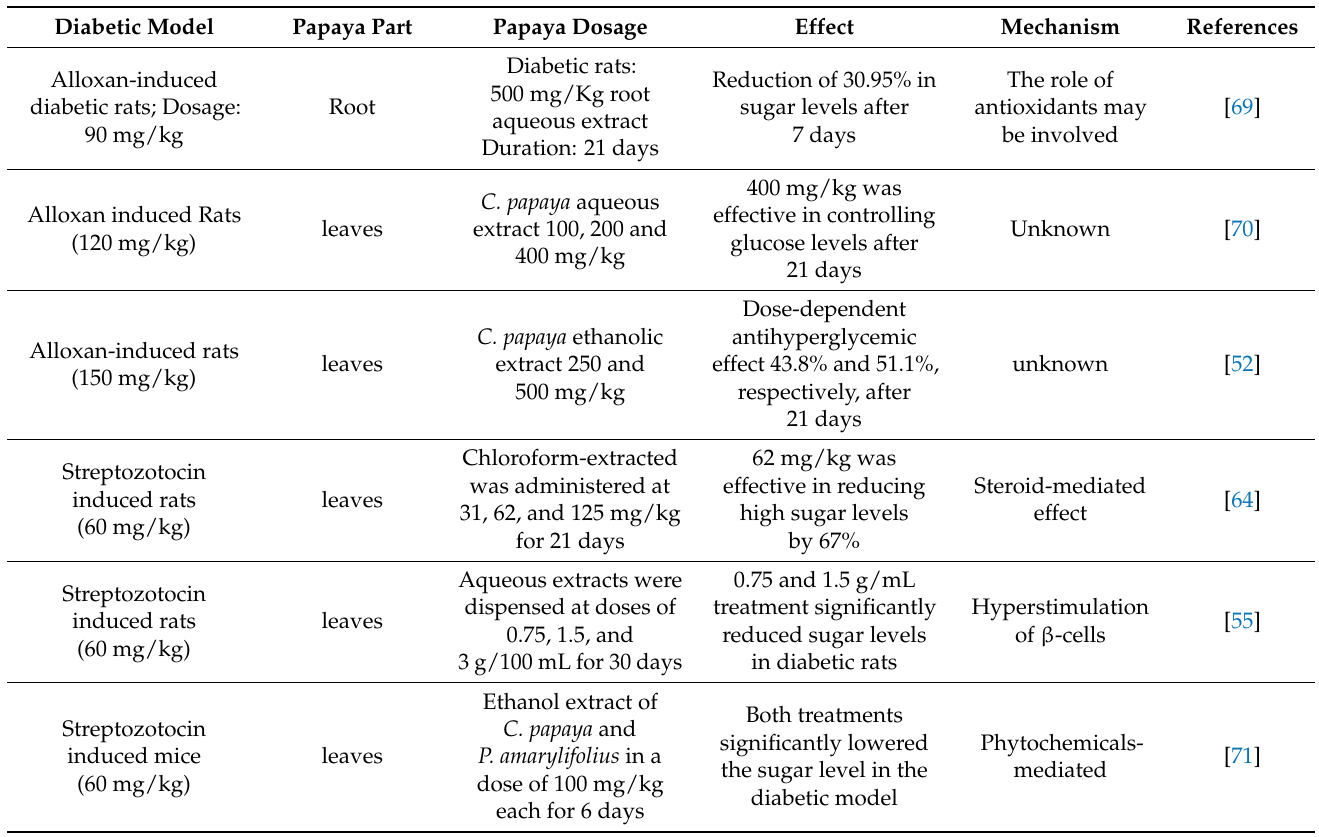
Table 1. Antidiabetic properties of crude papaya extracts in experimental animal